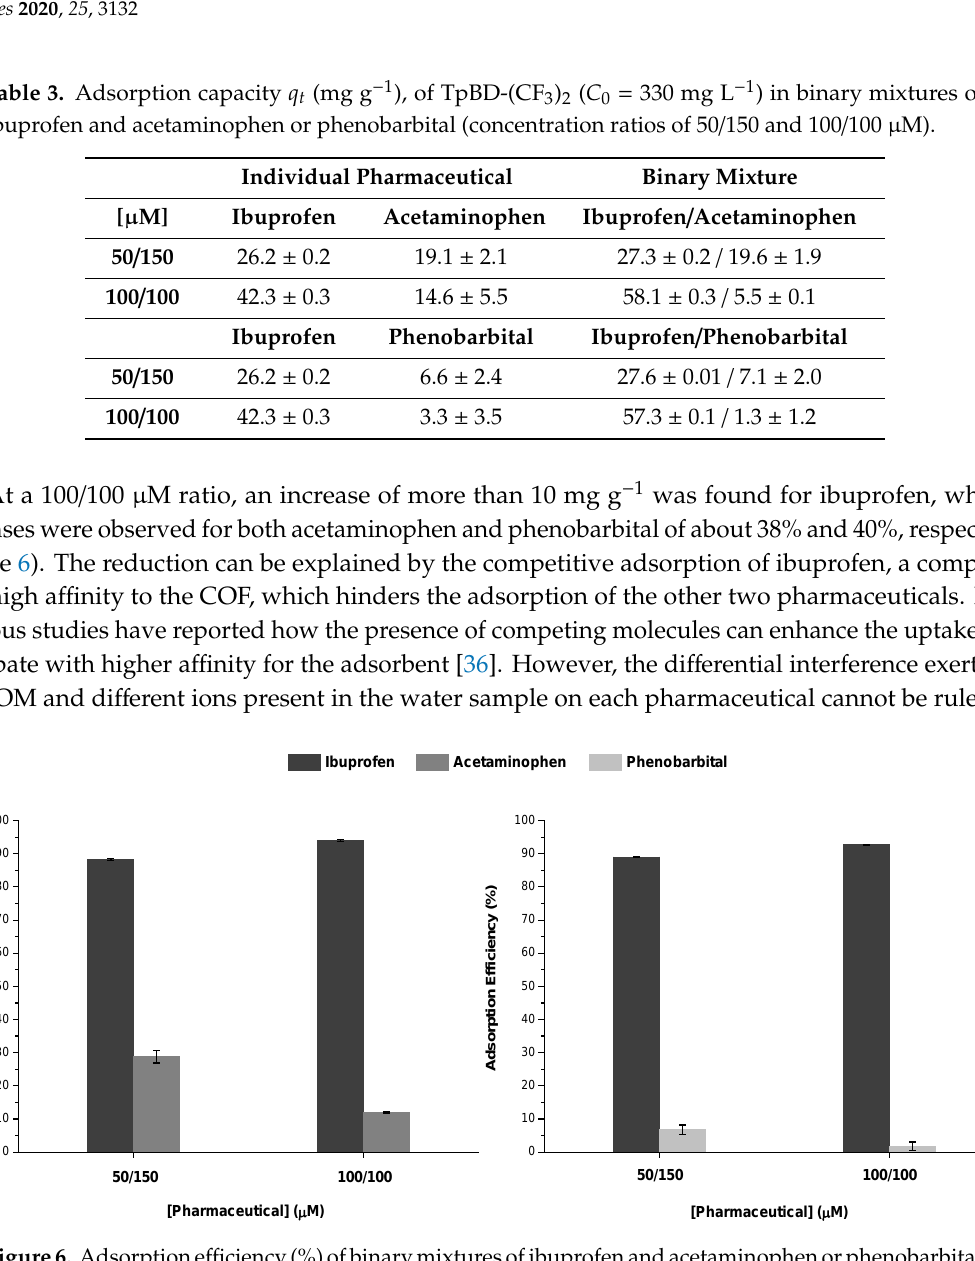
Figure6. Adsorptione ffi ciency(%)ofbinarymixturesofibuprofenandacetaminophenorphenobarbital, Figure 6. Adsorption efficiency (%) of binary mixtures of ibuprofen and acetaminophen or at concentration ratios of 50 / 150 and 100 / 100 µ M using TpBD-(CF 3 ) 2 ( C 0 = 330 mg L − 1 ) as adsorbent in phenobarbital, at concentration ratios of 50/150 and 100/100 µM using TpBD-(CF 3 ) 2 ( C 0 = 330 mg L − 1 ) lake water as adsorbent in lake water samples.